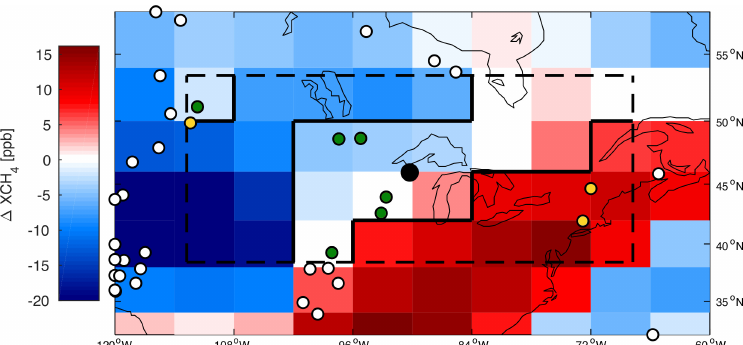
Figure 3. An example of the dynamical co-location technique at the Park Falls TCCON site on 2 September 2009. All GOSAT/NIES v02.75 soundings from that day are shown with white, green and yellow filled dots, while the black dot denotes the location of the TCCON station. The background is the difference between the modeled XCH 4 field and modeled XCH 4 at the TCCON location, both from the CTE–CH 4 model, i.e., ∆ XCH 4 = XCH 4, j − XCH 4, T , where j denotes any grid box and T the grid box of the TCCON site. The dashed line shows the maximum geographical limits around the site, and the solid black line denotes the ± 5 ppb air mass. White dots are NIES soundings rejected by the maximum geographical limit, yellow dots are eliminated by the modeled air mass and the green dots denote the NIES soundings that passed the co-location